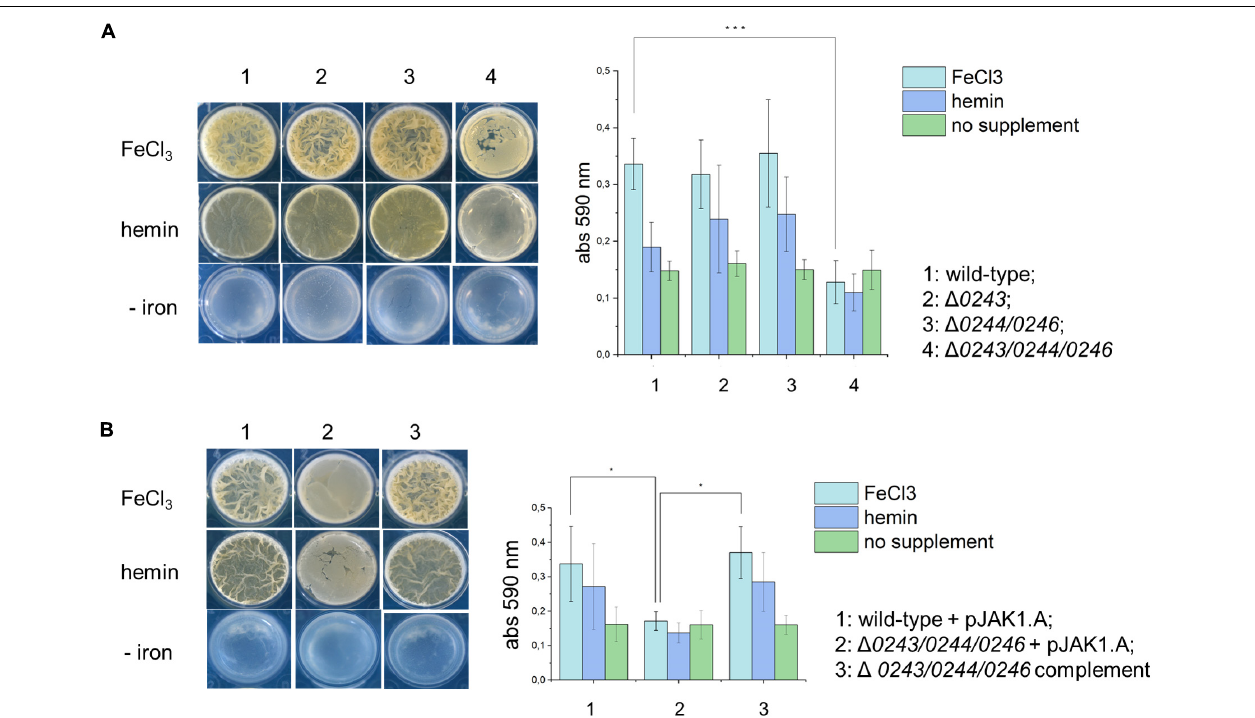
FIGURE 4 | A top-down view of biofilms from M. smegmatis mc 2 155 wild-type, knockout mutants and complemented strain in detergent-free Sauton’s medium, either with or without supplemental iron (10 µ M FeCl 3 or 10 µ M hemin) after 4 days of incubation. (A) 1: wild-type; 2: (cid:49) 0243 ; 3: (cid:49) 0244/0246 ; 4: (cid:49) 0243/0244/0246 . Bar graph represents biofilm quantification using crystal violet stain from triplicate experiments. Error bars represent ± SEM. *** p < 0.0005 (ANOVA test). (B) 1: wild-type + pJAK1.A; 2: (cid:49) 0243/0244/0246 + pJAK1.A; 3: (cid:49) 0243/0244/0246 complemented. Bar graph represents biofilm quantification using crystal violet stain from triplicate experiments. Error bars represent ± SEM. * p < 0.05 (ANOVA test). Light blue: FeCl 3 supplement, dark blue: hemin supplement and green: no supplement.